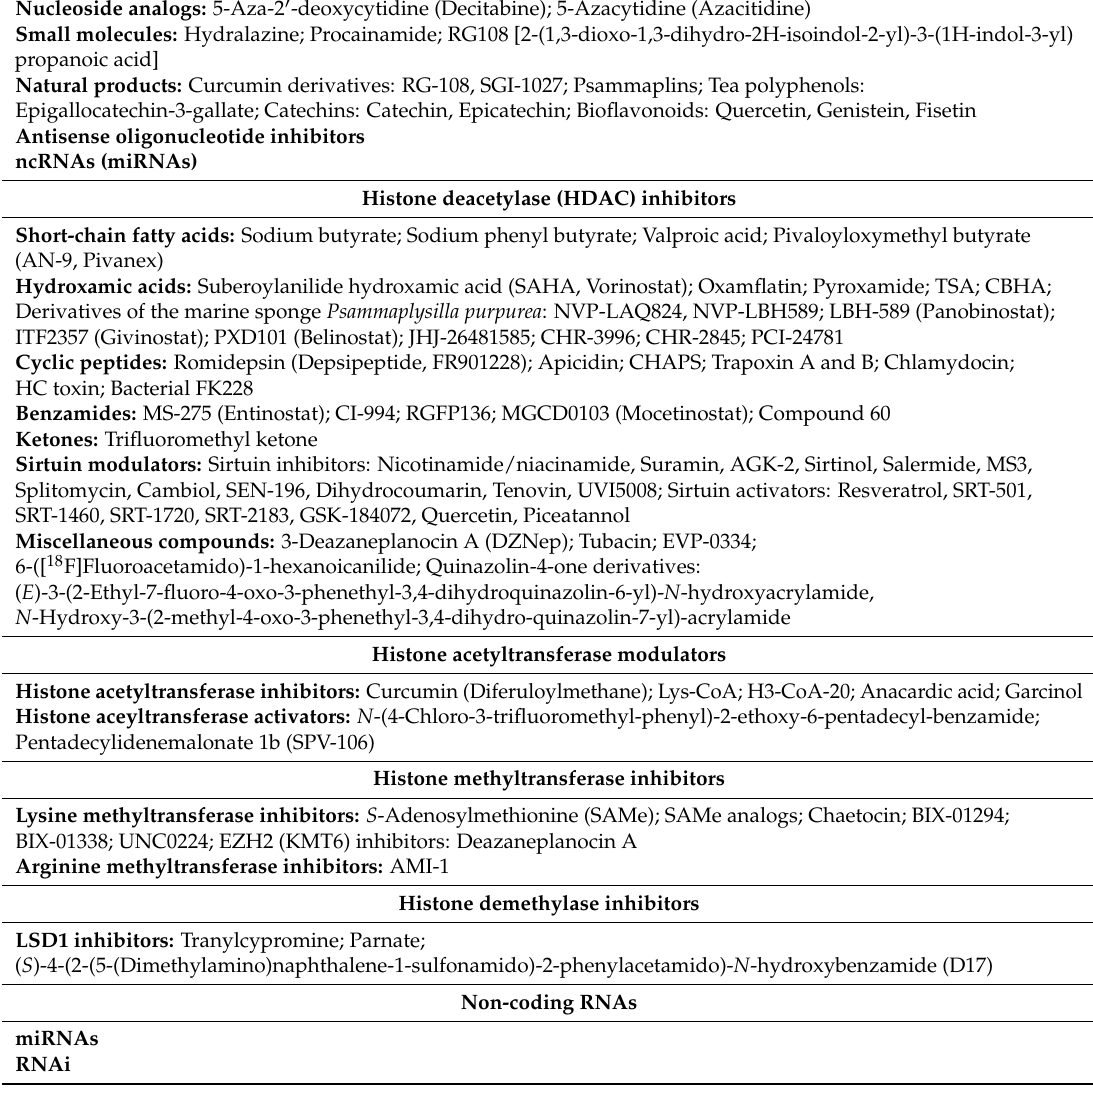
Table 1. Classification of selected epigenetic drugs. DNA Methyltransferase